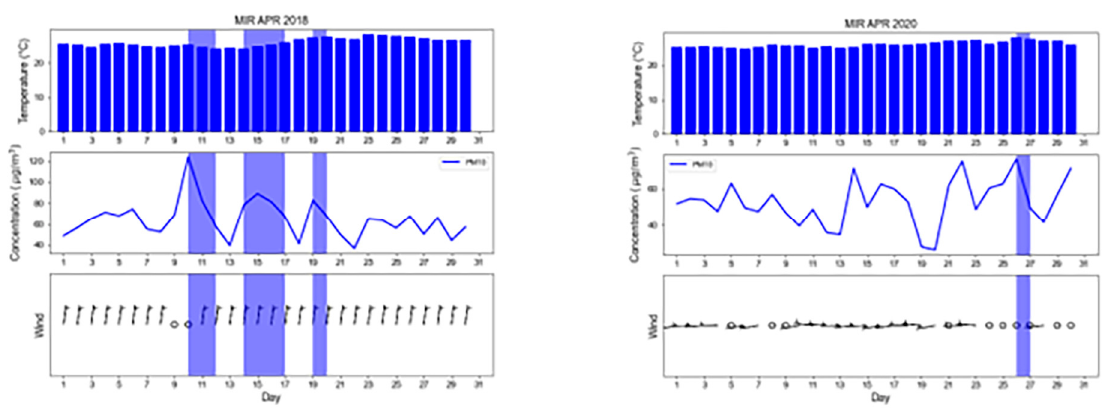
Figure A4. Meteograms for stations in Guadalajara with a significant relation between wind speed and PM concentrations. Blue bars represent days over the PM 10 maximum established by the national standard for air quality.